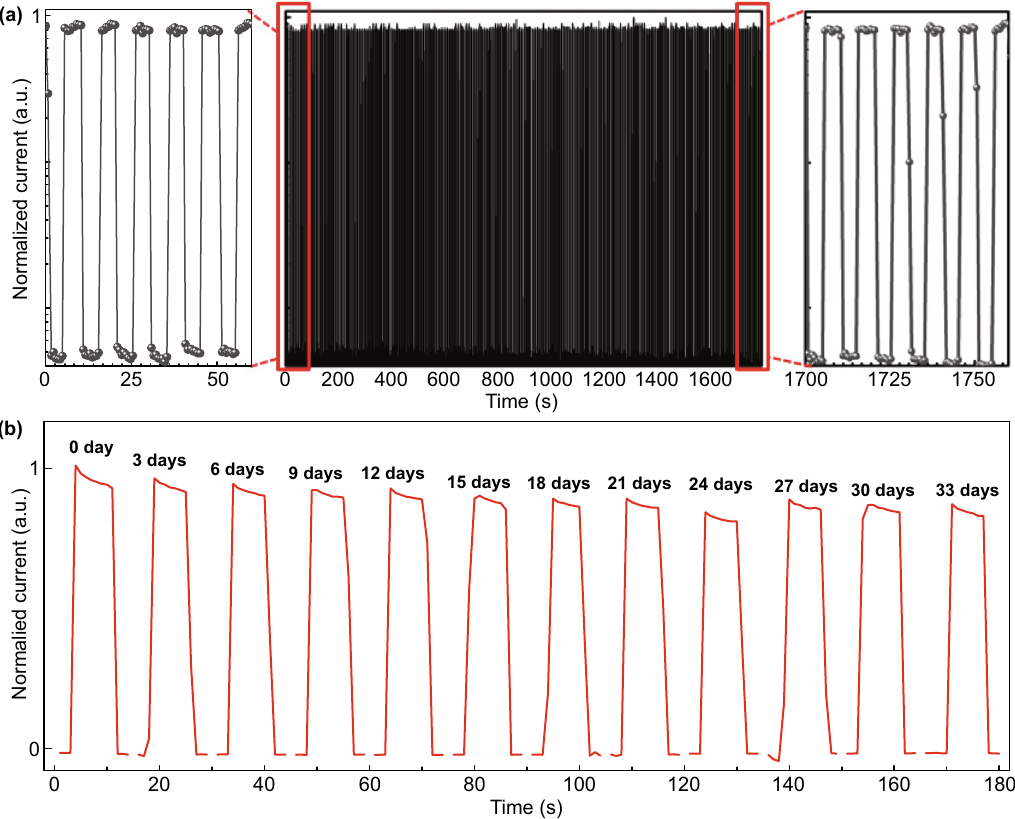
Fig. 5 a Longtime irradiation test and b storage stability of the unencapsulated device for 33